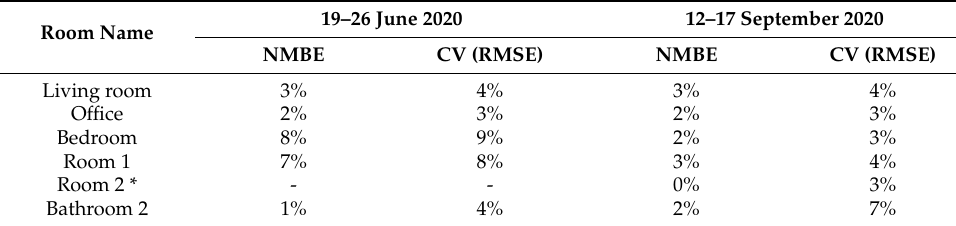
Table 7. Correlation coefficients R for measured and calculated hourly values for the entire meas- Table 4. Values of normalized mean bias error (NMBE) and coefficient of variation of root mean ured period. squared error (CV (RMSE)) indicators for periods without occupants.